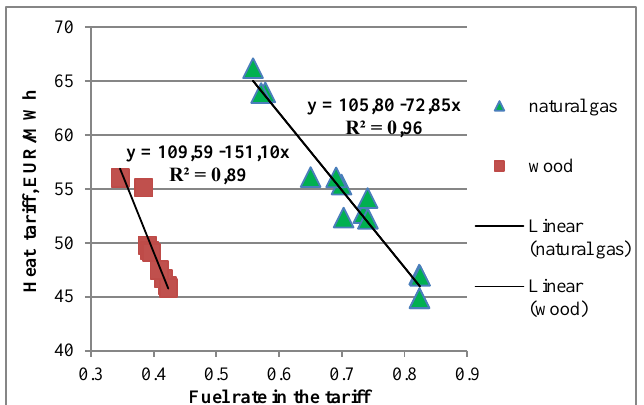
Fig. 5. Heat tariff depending on fuel rate in tariff.